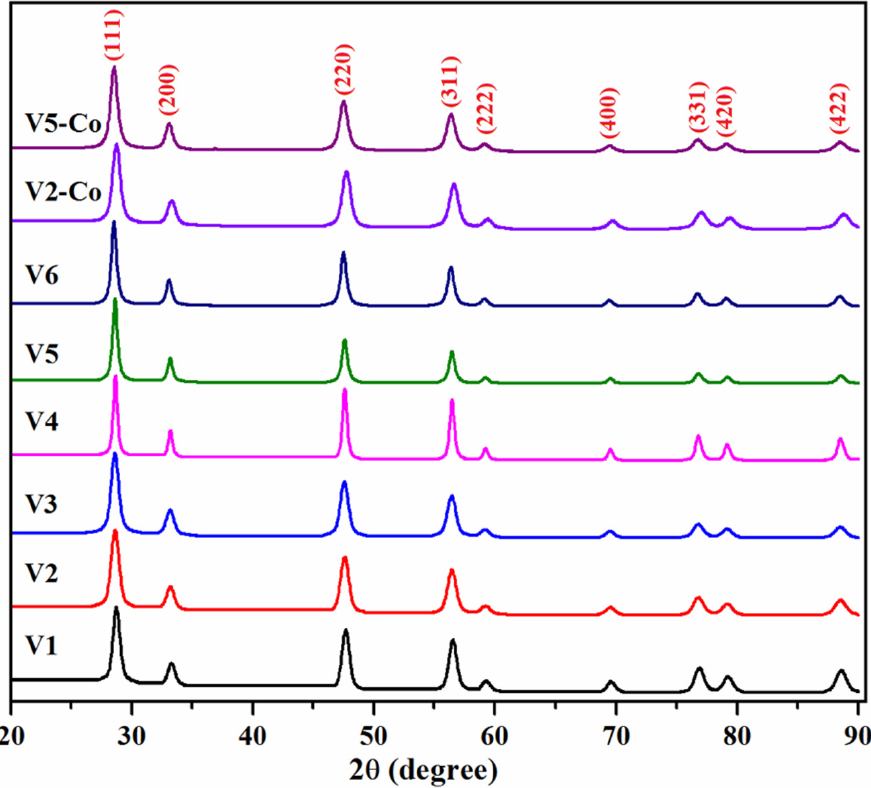
Figure 2. XRD patterns of CeO 2 /Co-doped CeO 2 nanoparticles. The estimation of the crystallite sizes of the samples was performed using Scherrer’s formula, d = K λ / β cos θ , where d is the crystallite size, K is the so-called shape factor, which usually takes a value of about 0.9, λ is the X-ray wavelength of the radiation source (1.5406 Å), β is the full-width at half-maximum (FWHM) of the diffraction peak, and θ is the Bragg angle. The crystal size varies between 11.24 and 21.65 nm (Table 2). The nanoparticles with smallest crystallite sizes (~11–12 nm) were obtained through the reactions achieved at pH 8 and 10 (V1–V3 samples), while the pH variation at more extreme values (4 or 12) leads to a doubling of the crystallite dimension (~20 nm) of the nanoparticles (V4–V6 samples). If CeO 2 NPs are intended to be use as photocatalysts, the ones with a smaller crystallite size are preferred, since the charge migration pathway to the surface is reduced compared to the ones with larger dimensions, thus resulting in a decrease in the recombination rate of the charge carriers [44,45]. Moreover, it can be observed that the increase in the reaction time (in the case of V3 and V6 samples) does not cause a significant change in the size of the crystallites. The inclusion of Co atoms in the V2 sample does not notably influence the crystallites’ growth, while, for sample V5-Co, a decrease in the crystallite size was observed, a finding that could be attributed to the replacement of Ce ions with Co-dopant ions, as previously reported by Ranjith et al.